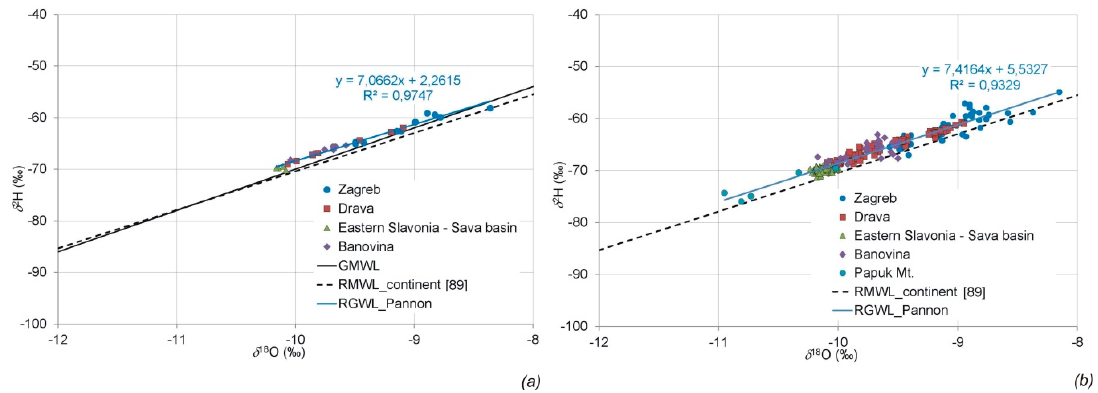
Figure 6. The regional meteoric water line of the continental part of Croatia (RMWL_continent) and the stable isotope composition of spring water in the Pannonian part in Croatia: ( a ) the mean values of stable isotopes and ( b ) the single values of stable isotopes.